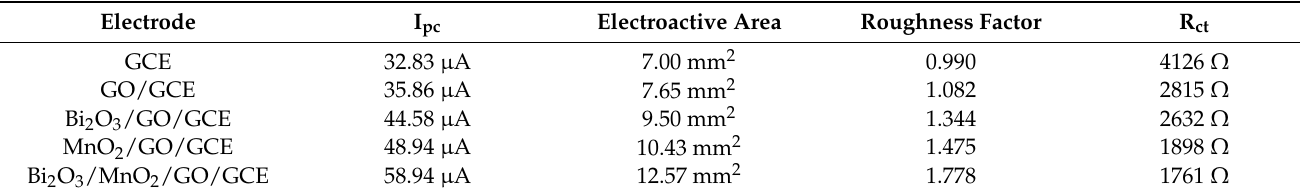
Figure 3. The CV curves ( A ) and Nyquist plots ( B ) of the bare GCE, GO/GCE, Bi 2 O 3 /GO/GCE, MnO 2 /GO/GCE, and Bi 2 O 3 /MnO 2 /GO/GCE recorded in a 10 mL solution of 2.0 mM [Fe(CN) 6 ] 3 − /4 − and 0.1 M KCl. Table 1. A comparison of the electrochemical properties of different